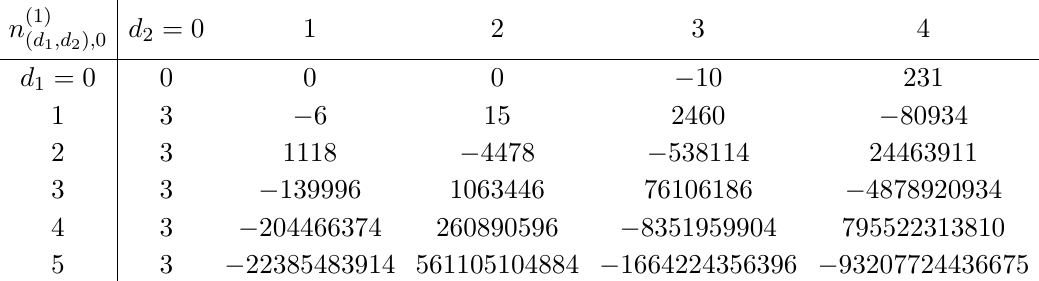
Table 10 . Genus 1 torsion refined Gopakumar-Vafa invariants with Z 2 charge 0 .